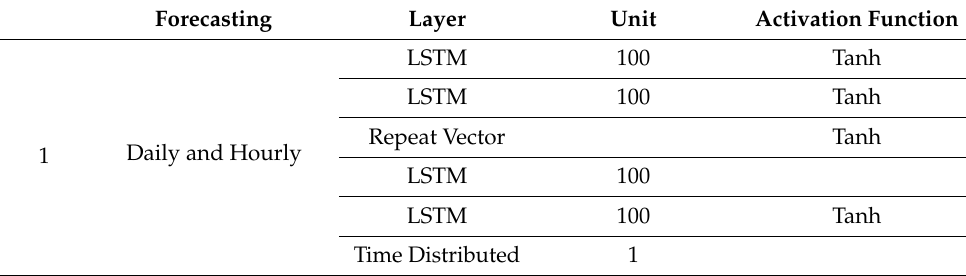
Table 5. The model architecture of the daily and hourly LSTM encoder–decoder model. Forecasting Layer Unit Activation Function